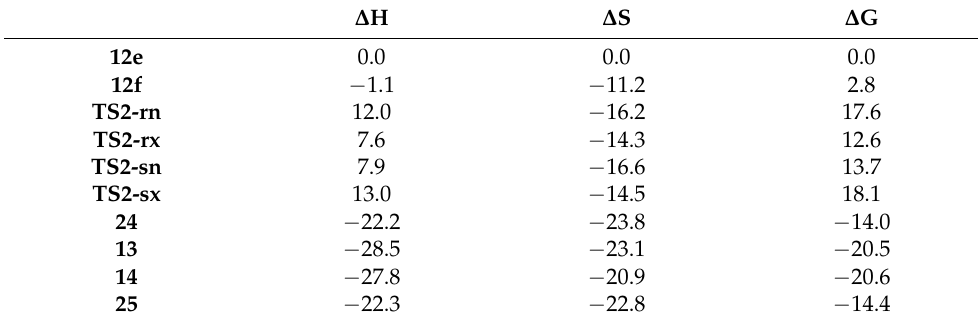
Table 5. ω B97XD/6-311G(d,p) relative enthalpies ( ∆ H, in kcal · mol − 1 ), entropies ( ∆ S, in cal · mol − 1 · K), and Gibbs free energies ( ∆ G, in kcal · mol − 1 ) with respect to the most stable conformation 12f , computed at 75 ◦ C and 1 atm in ethanol, of the stationary points involved the IIDA reactions of dieniminium 12 . ∆